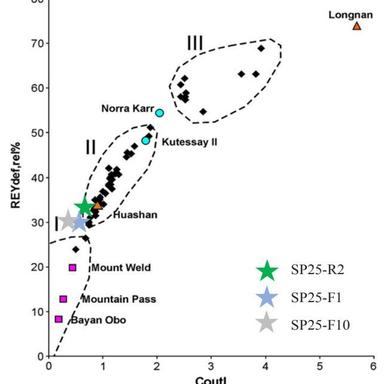
Evaluation of REEs in the SP25-R2, SP25-F1, and SP25-F10 segments of the Guxu coalfield (REEs of the three core samples are labelled as stars and the figure is referred to Seredin and Dai).